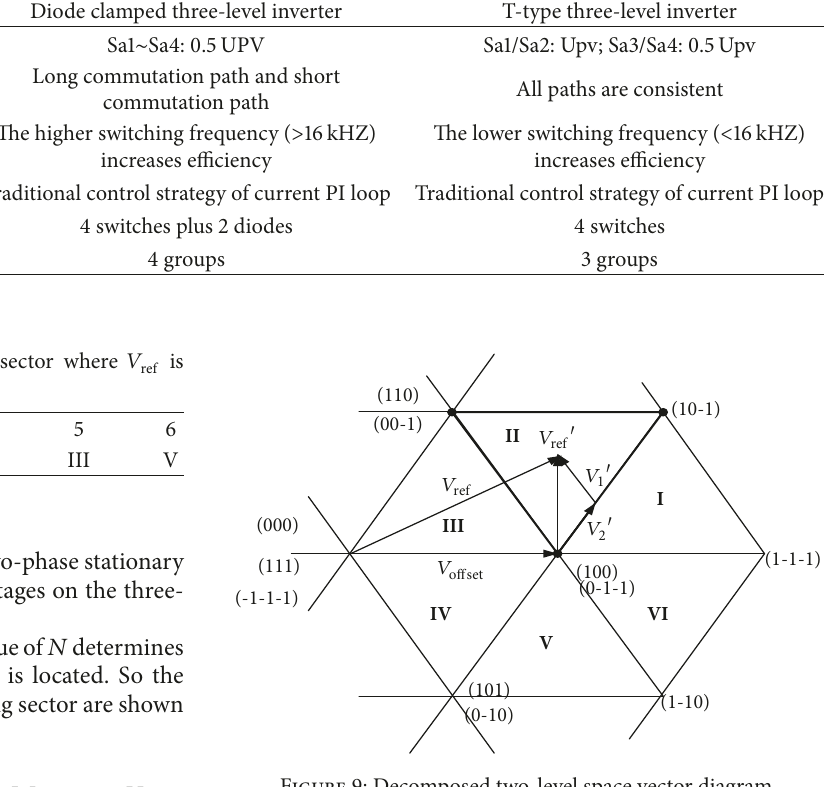
Figure 9: Decomposed two-level space vector